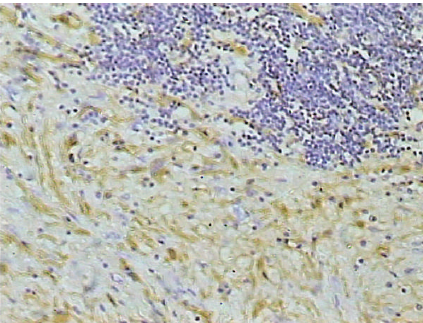
Figure 3: Intraoperative photograph showing giant tumour with right ureter passing anteriorly.